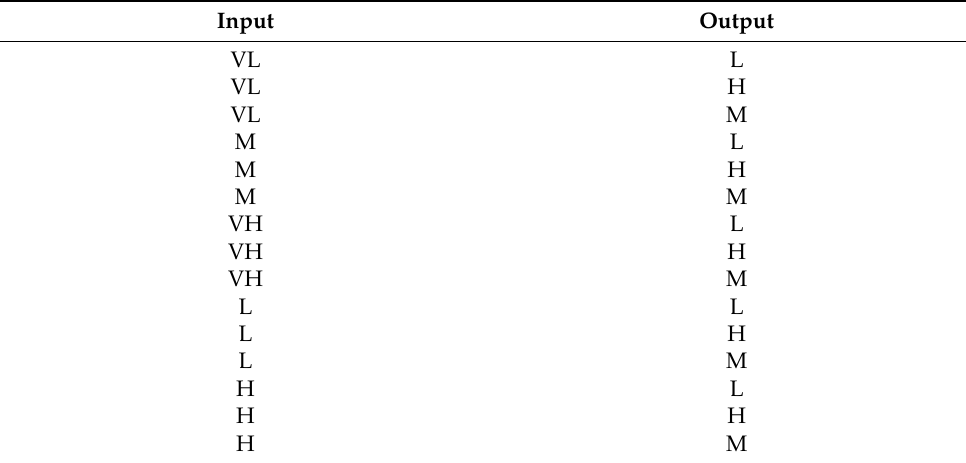
Figure 4. Best type-1 fuzzy system to control the insulin pump injection. Table 2. Rules used in the type-1 fuzzy system.